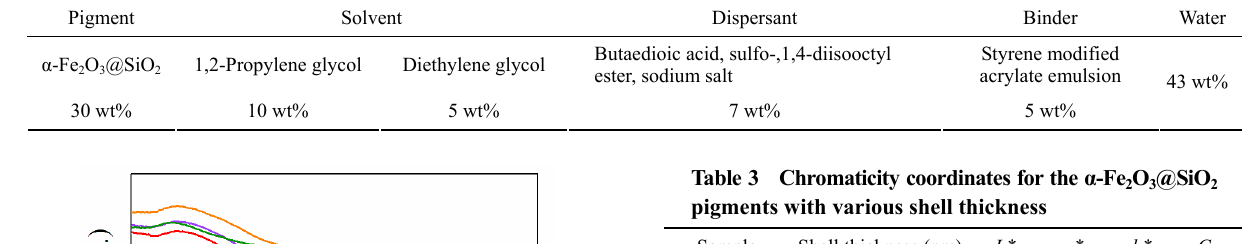
Table 2 Composition of the α-Fe 2 O 3 @SiO 2 ceramic ink